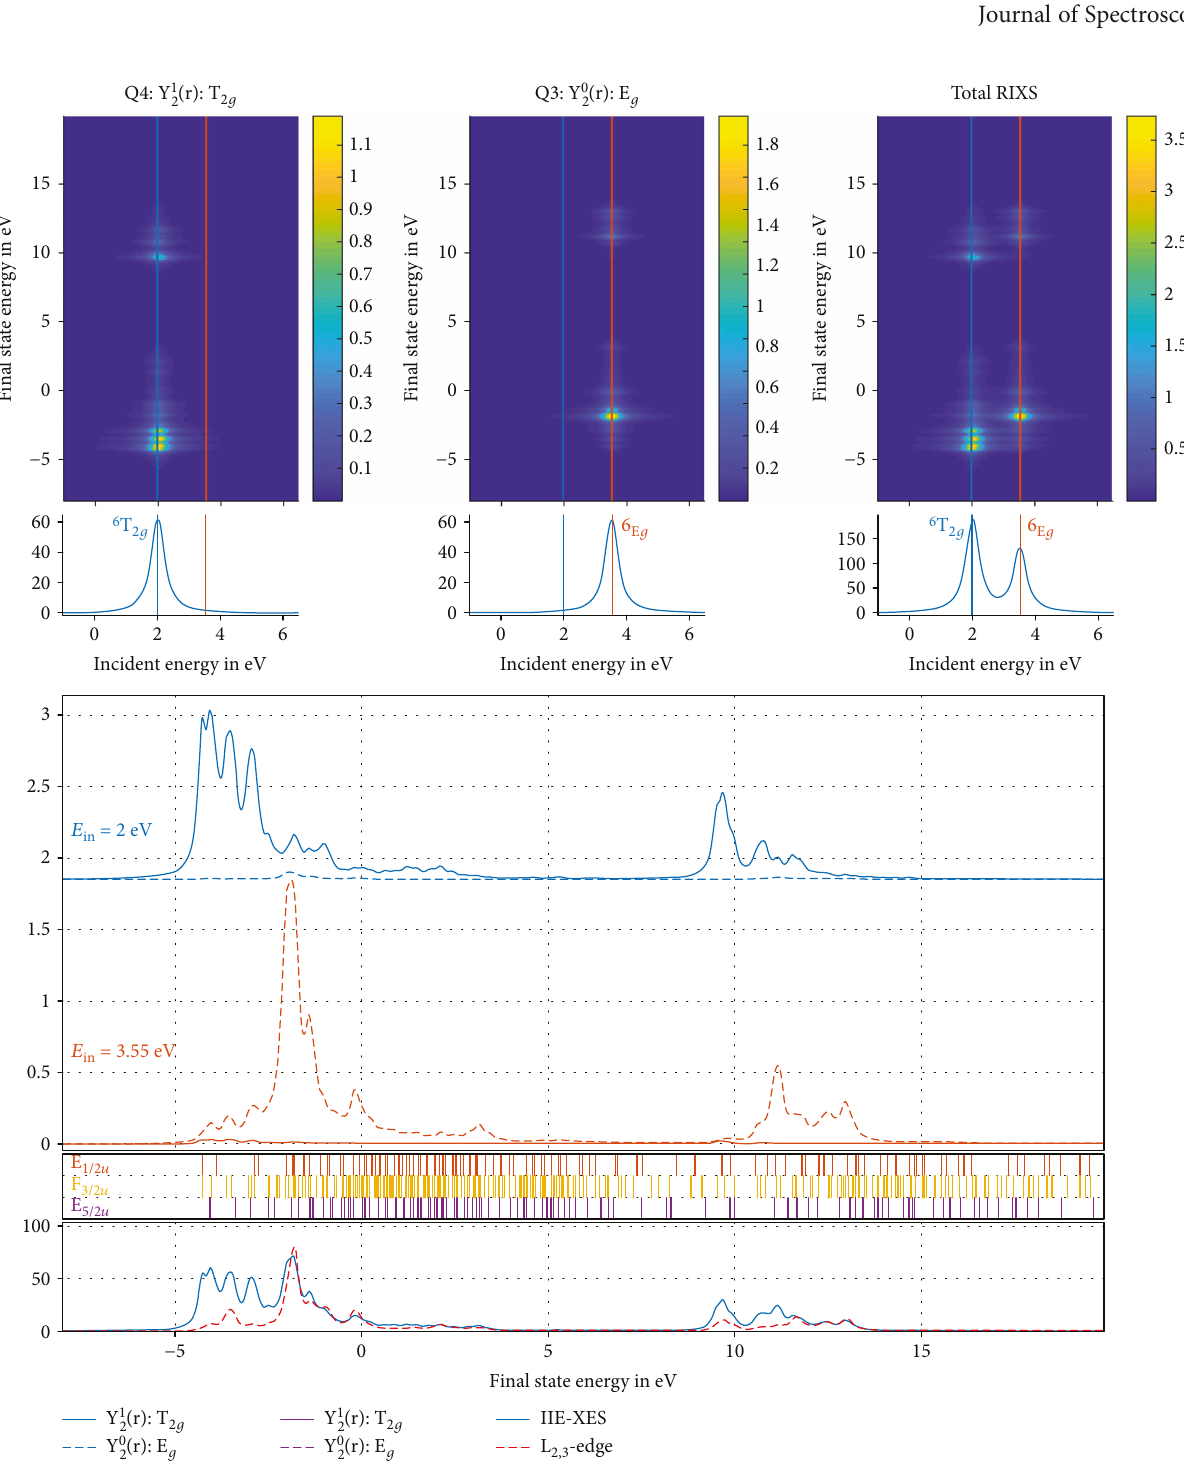
Here, the term T lies the lowest in energy; thus, the 2 g ground state is 5 T T (O ). 2 g 2 g h ( 2 ⋅ 120 = 240 microstates) yields the atomic terms 1 , 3 , 5 F , 1 , 3 , 5 P , 1 , 3 D , 1 , 3 G , and 1 , 3 H (Table 1). Using Table 2, one fi nds the branchings of the atomic states in an O crystal fi eld h which are analogue to the Tanabe-Sugano diagram of 3d 7 .